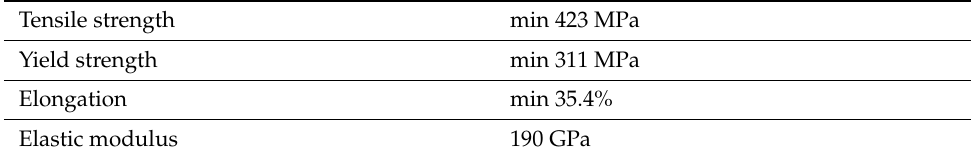
Table 1. Mechanical properties of S20C (JIS) steel